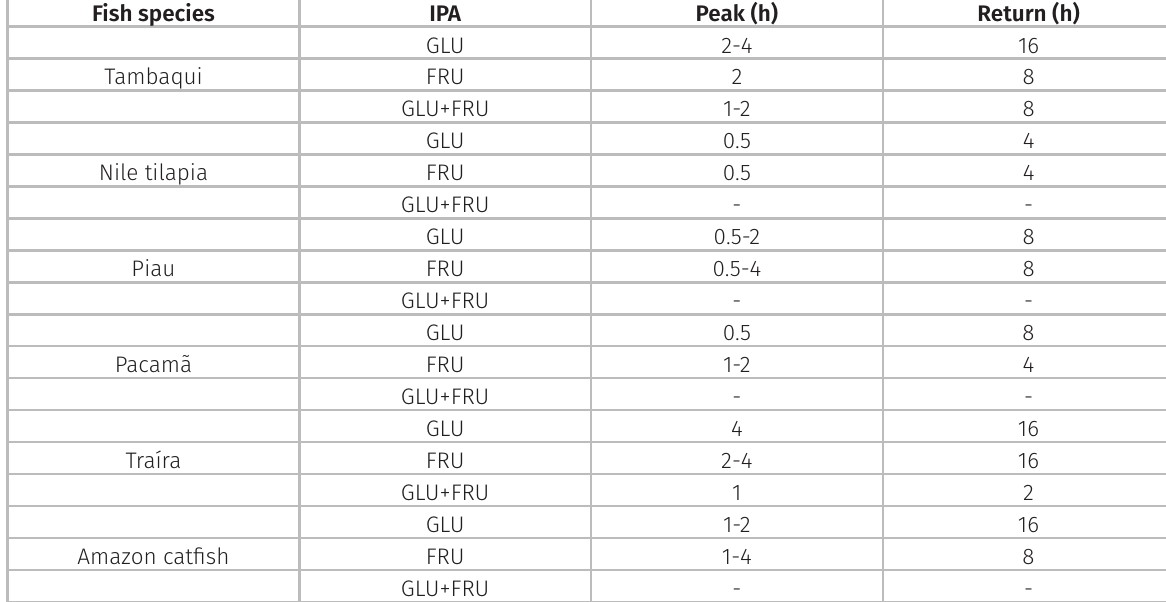
Table I. Time of blood glucose peak and retorn to baseline levels over a 24-h period for six fish species submitted to intraperitoneal administration (IPA) of glucose (GLU), fructose (FRU) or glucose + fructose (GLU+FRU) (1000 mg kg body weight -1 ). Fish species